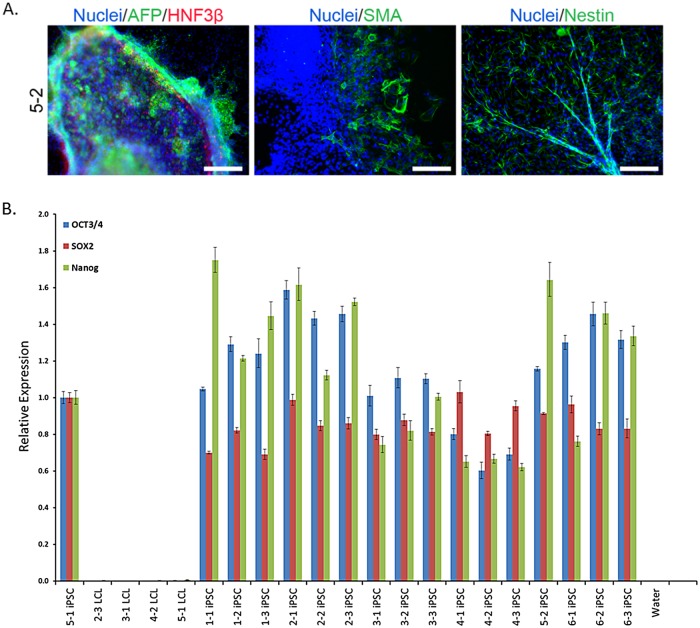
iPSC generation and validation.A. Representative embryoid body staining for iPSC line 5–2 demonstrating differentiation potential for endoderm, mesoderm, and ectoderm lineages. See S1 Fig for results from all lines. Scale bars represent 200 μm B. Results from qPCR for three endogenous pluripotency-related transcription factors, normalized to GAPDH. iPSC 5–1 was randomly chosen as a reference sample.